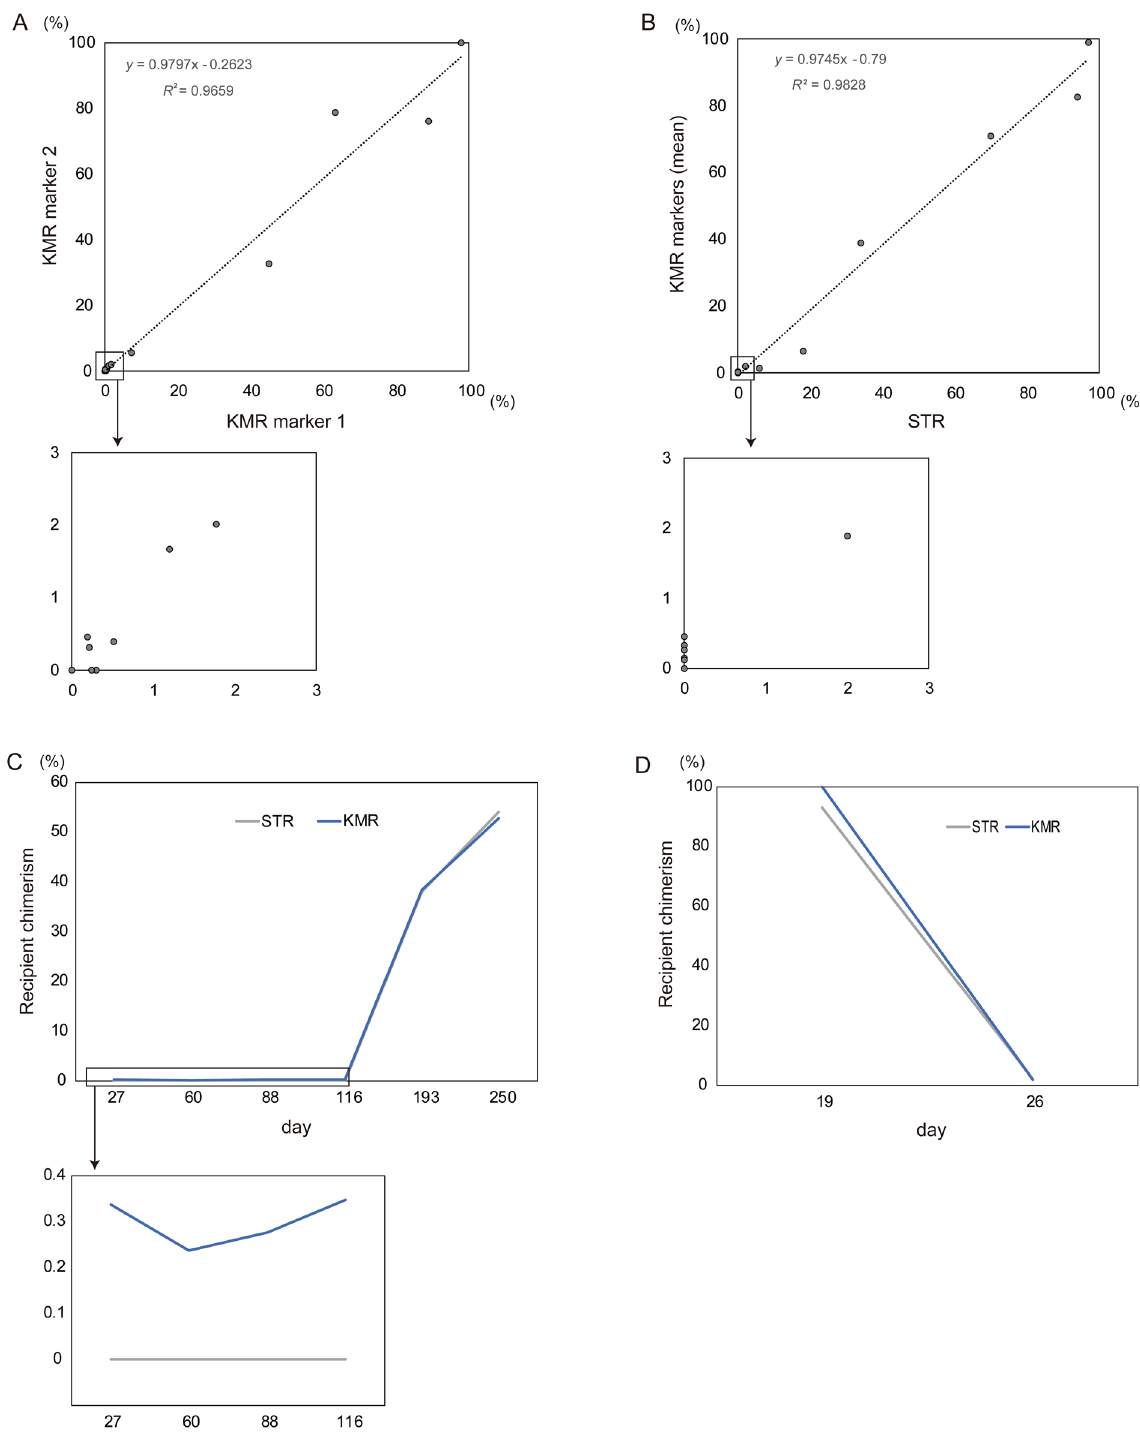
Figure 5. Validation of chimerism monitoring by KMR method. ( A ) Correlation between recipient chimerism evaluated with one KMR marker and another. ( B ) Correlation between means of recipient chimerism levels in couples of KMR markers and results of STR-PCR method. ( A, B ) Levels of recipient chimerism are shown as percentages in each sample. ( C, D ) Kinetics of changing chimerism in patients with relapsing ( C ) or engrafting ( D ). KMR results are indicated as means of multiple markers, except day 19 in which sample was not available for additional KMR examination due to the low cell number. Detailed data are depicted in Supplemental Tables 3, 4,